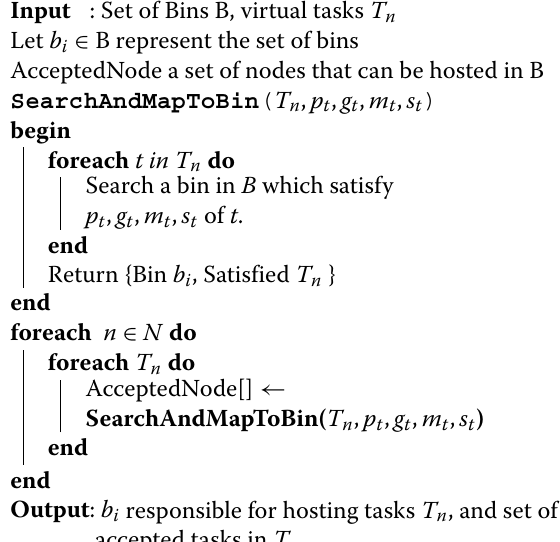
Algorithm 1: Adaption of Bin Packing proposed in [11] for MEC-DCs resources allocation